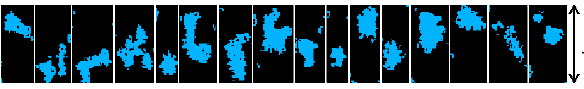
Fig. 6. Examples of cloud particle shadow-cast images collected by the CIP when crossing the MCS anvil and outflow while descending on 7 August 2006.